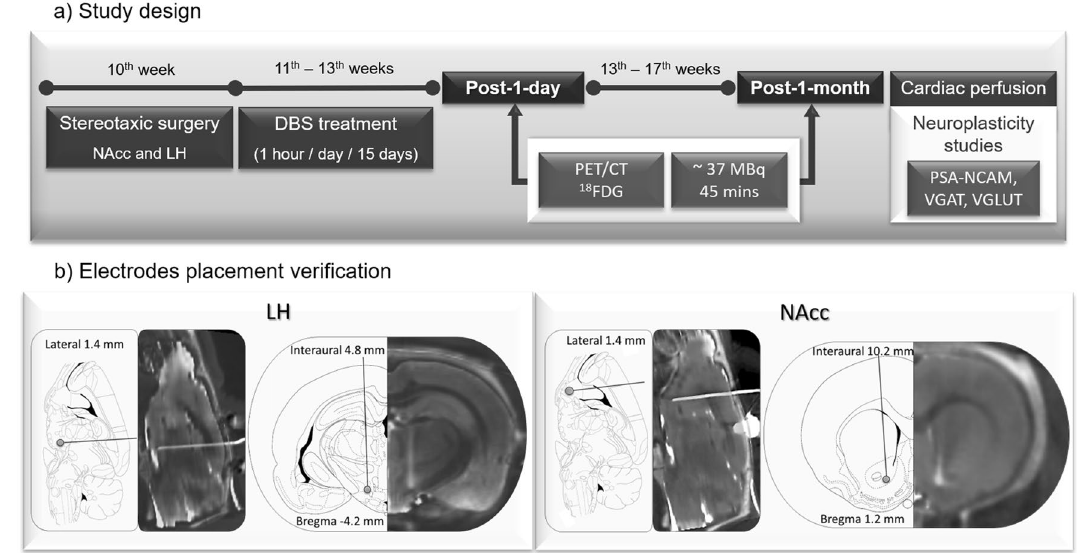
Figure 1. ( a ) Study design. Design of the experimental procedures performed during the study. ( b ) Electrodes placement verification. Sagittal and axial views of a CT scan of an animal registered to the MR template next to the correspondent slice from 38 to verify the correct electrode location in LH (left) and NAcc